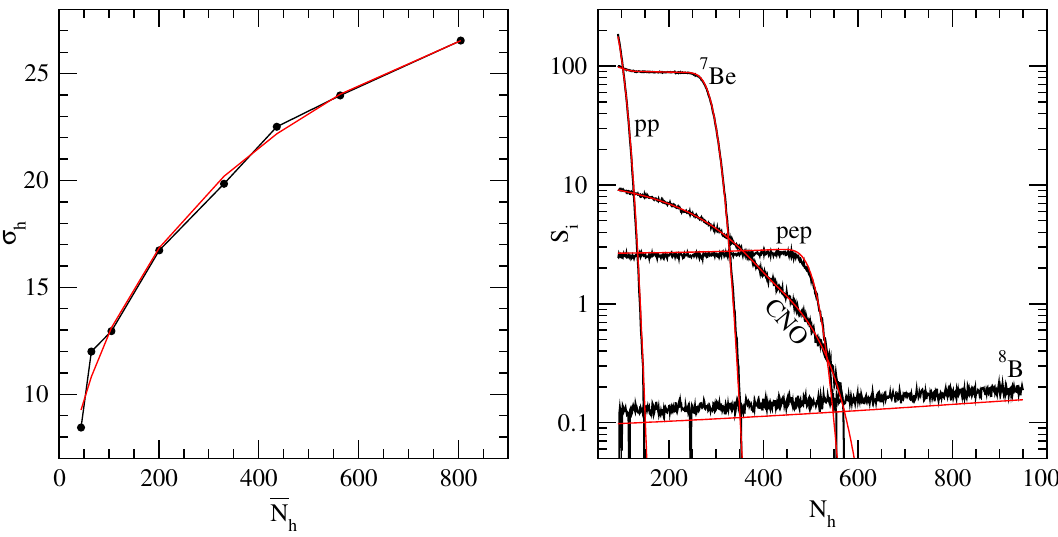
Figure 7 . Left: our choice of the energy resolution function, based on the relation between σ h and ¯ N h inferred from the upper panel of figure 22 of ref. [22]. Right: our reconstruction of solar spectra after the optimization of the energy scale